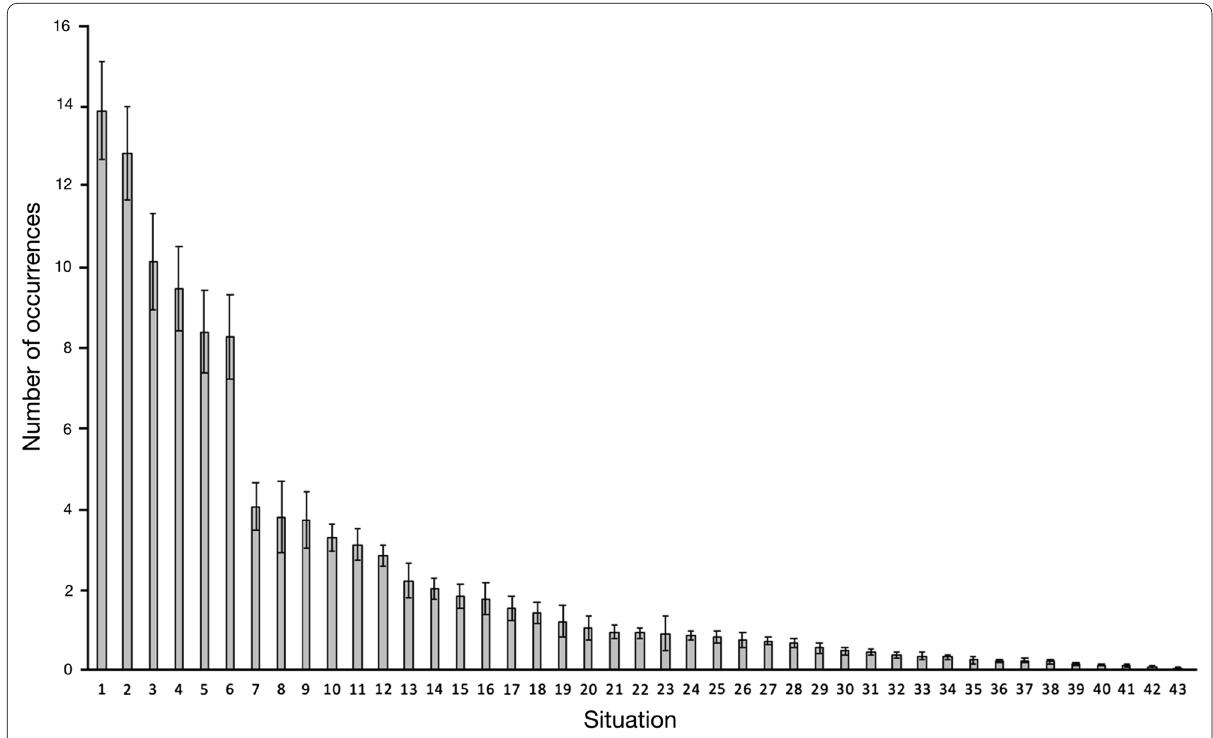
Fig. 1 Mean number of occurrences (